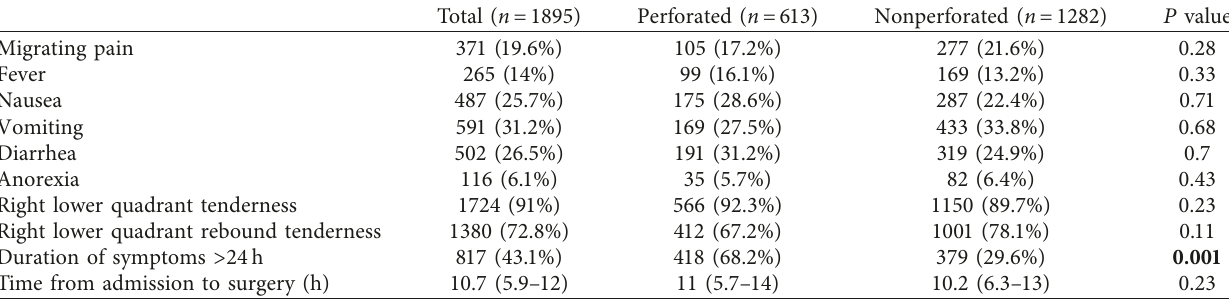
Table 2: Symptoms and signs of children with acute appendicitis.